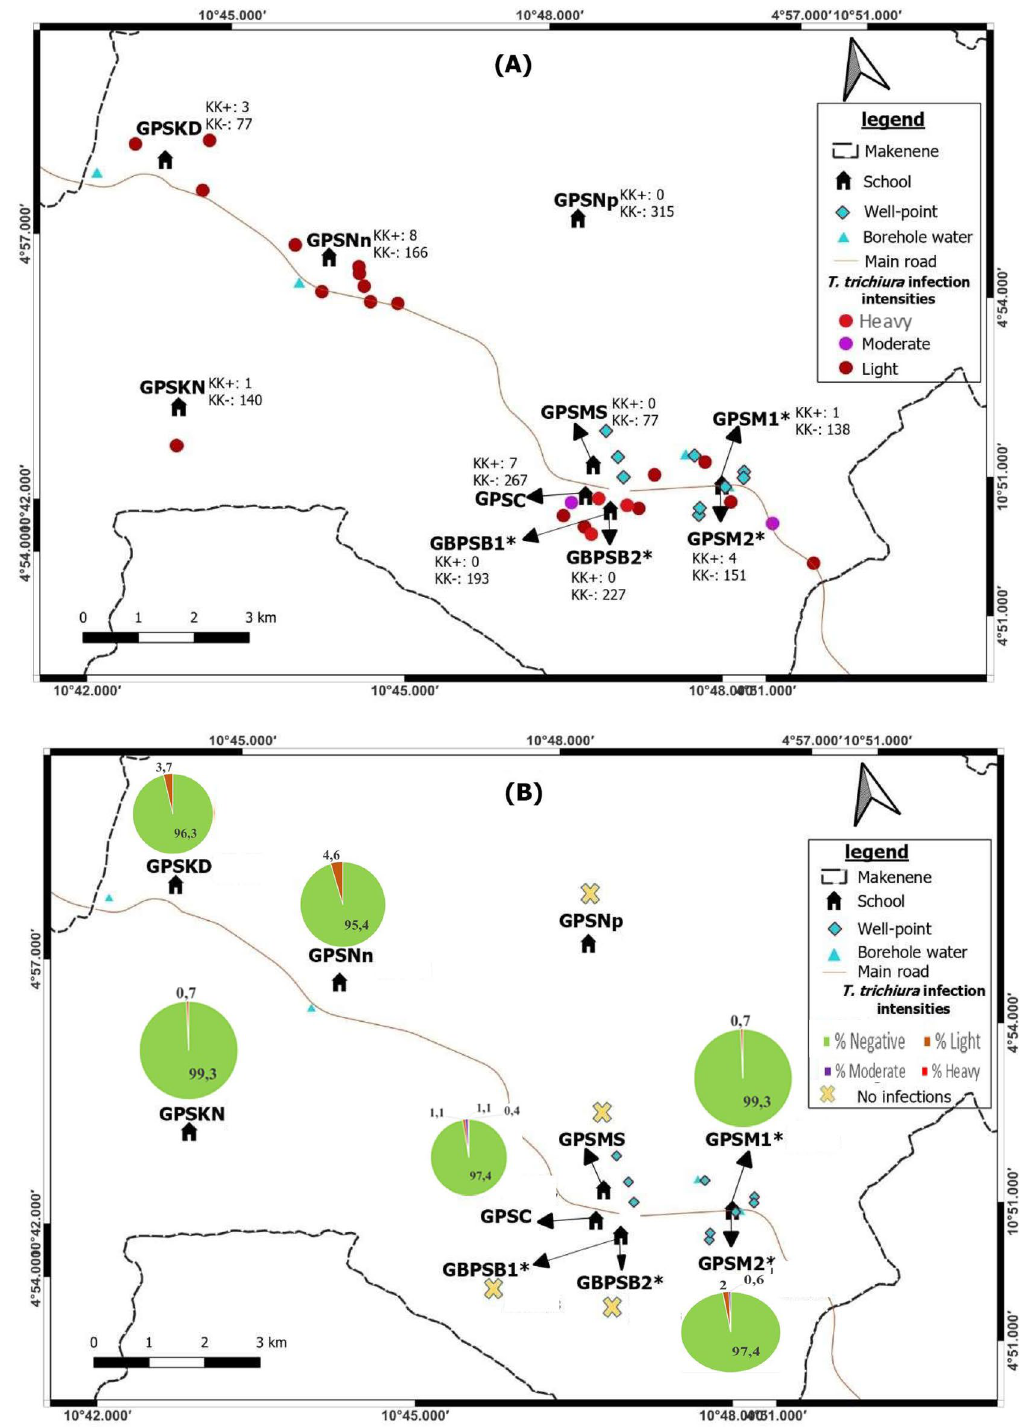
Figure 4. Map showing spatial distribution of Trichuris trichiura infections ( A ) and its infection intensities ( B ) according to schools (*both schools are hosted on the same building). GBPSB1: Government Bilingual Primary School of Baloua Group 1; GBPSB2: Government Bilingual Primary School of Baloua Group 2; GPSM1: Government Primary School of Makenene Group 1; GPSM2: Government Primary School of Makenene Group 2; GPSNn: Government Primary School of Nyokon; GPSKD: Government Primary School of Kinding Nde; GPSKN: Government Primary School of Kinding-Ndjabi; GPSMS: Government Primary School of Mock-Sud; GPSC: Government Primary School of Carrière; GPSNp: Government Primary School of